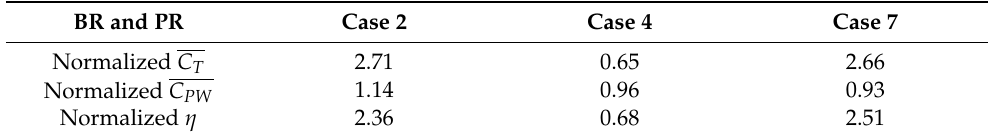
Table 3. Normalized cycle averaged